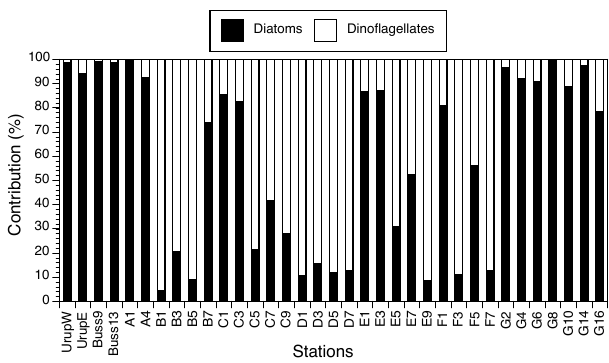
Fig. 10. Relative contributions (%) of diatoms and peridinin- containing dinoflagellates to the total micro-sized phytoplankton in terms of Chl a